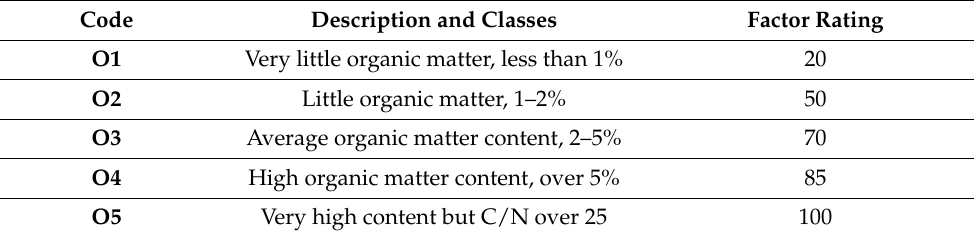
Table 9. Factor ratings of soil moisture content